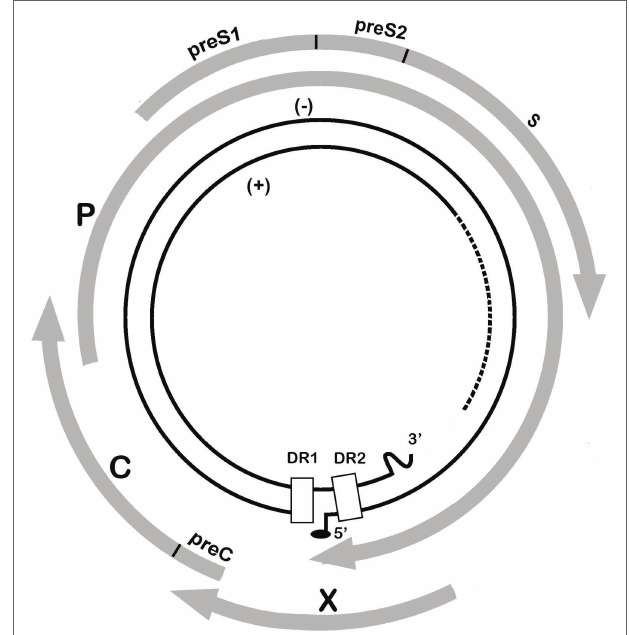
FIGURE 1 | Schematic representation of the HBV genome. The inner circles represent the partial double-stranded DNA molecule and location of the direct repeat (DR) sequences, while the solid gray arrows illustrate the four open reading frames in the HBV genome: polymerase (P), precore (preC), core (C), hepatitis b X protein (X), and envelope (preS1, preS2, and